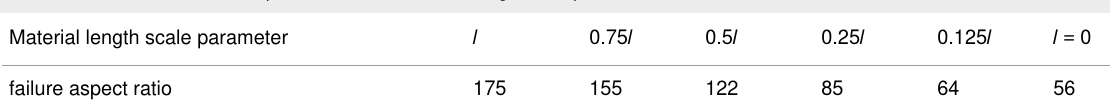
Table 9: Variation of the failure aspect ratio with the material length scale parameter.